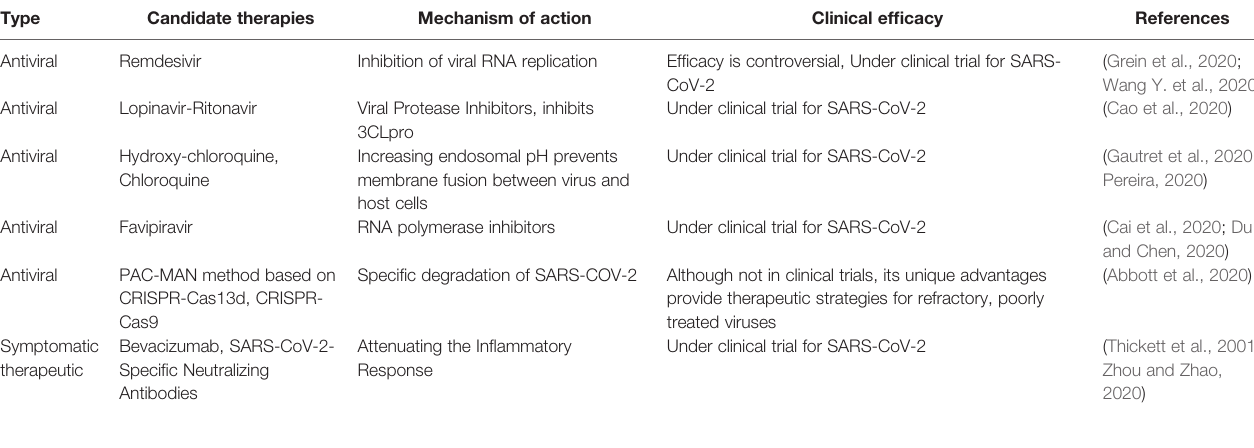
TABLE 3 | Summary of current antiviral drugs or approaches to treat COVID-19.